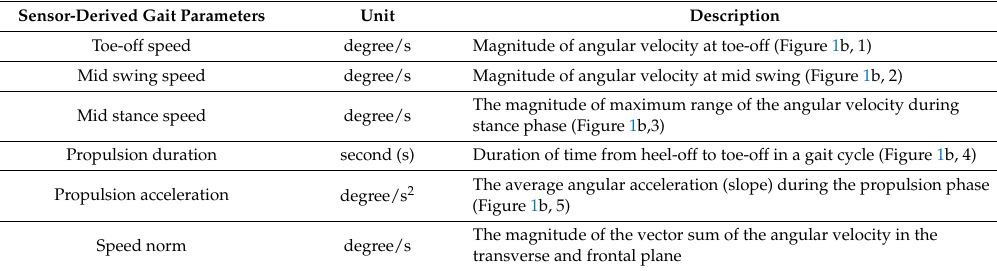
Table 1. Definition of the sensor-derived gait